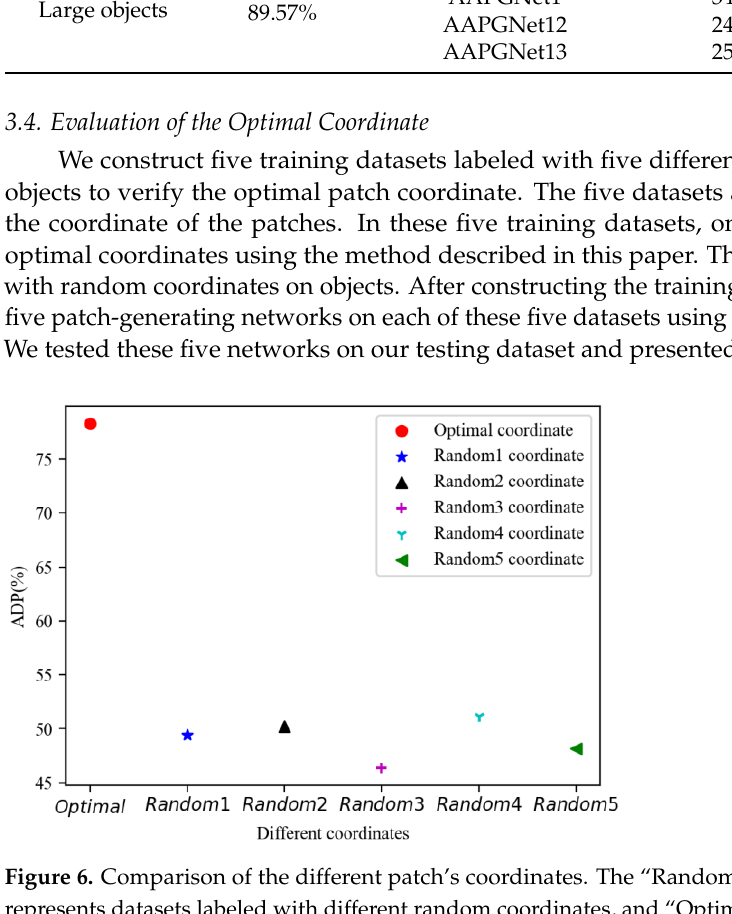
Table 2. Comparison of the different-shaped patches.